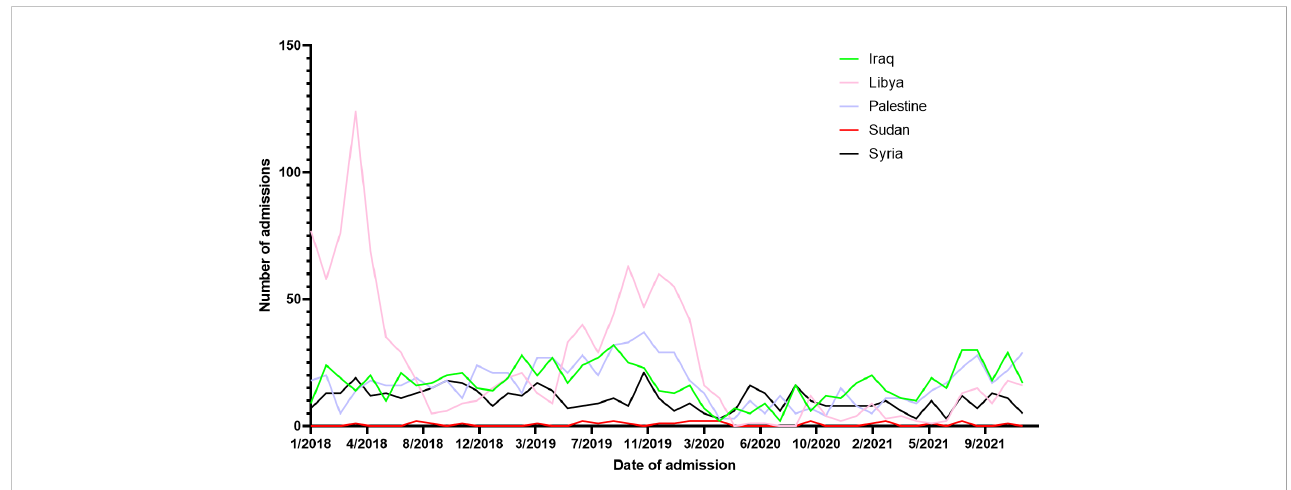
FIGURE 3 Admissions trends of patients from areas of con fl ict strati fi ed by nationality from 2018 to